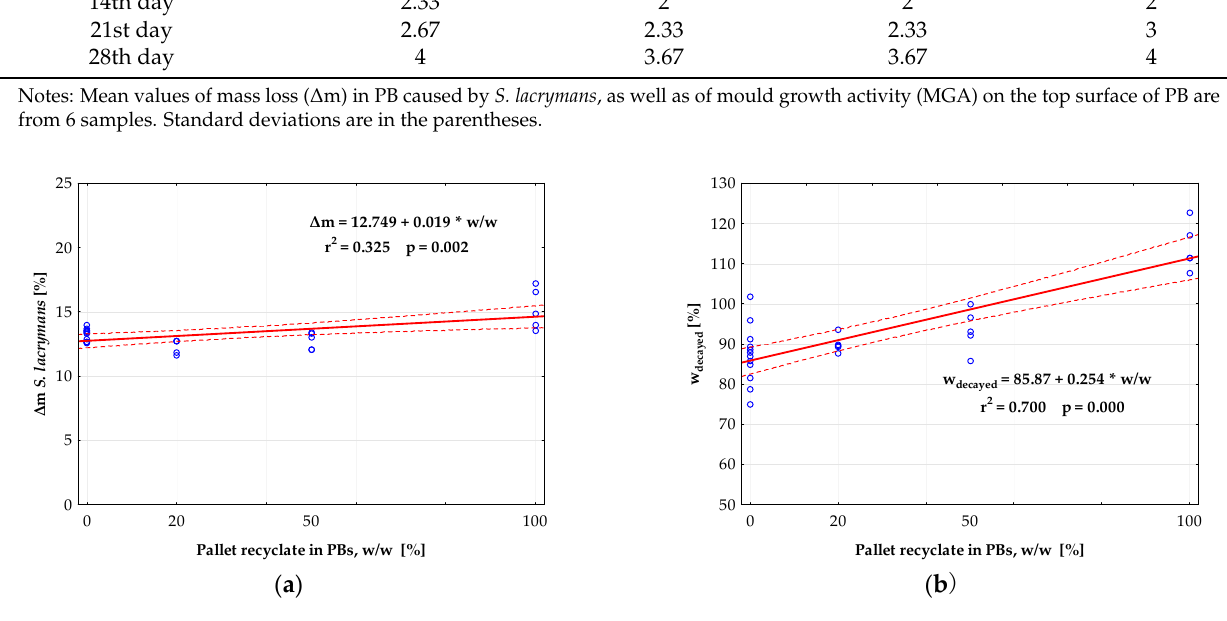
Figure 9. Mass loss ( ∆ m) ( a ) and moisture content (w decayed ) ( b ) of PBs containing different amount of particles from recycled spruce pallets (RSP) after attack by the brown-rot fungus S. lacrymans